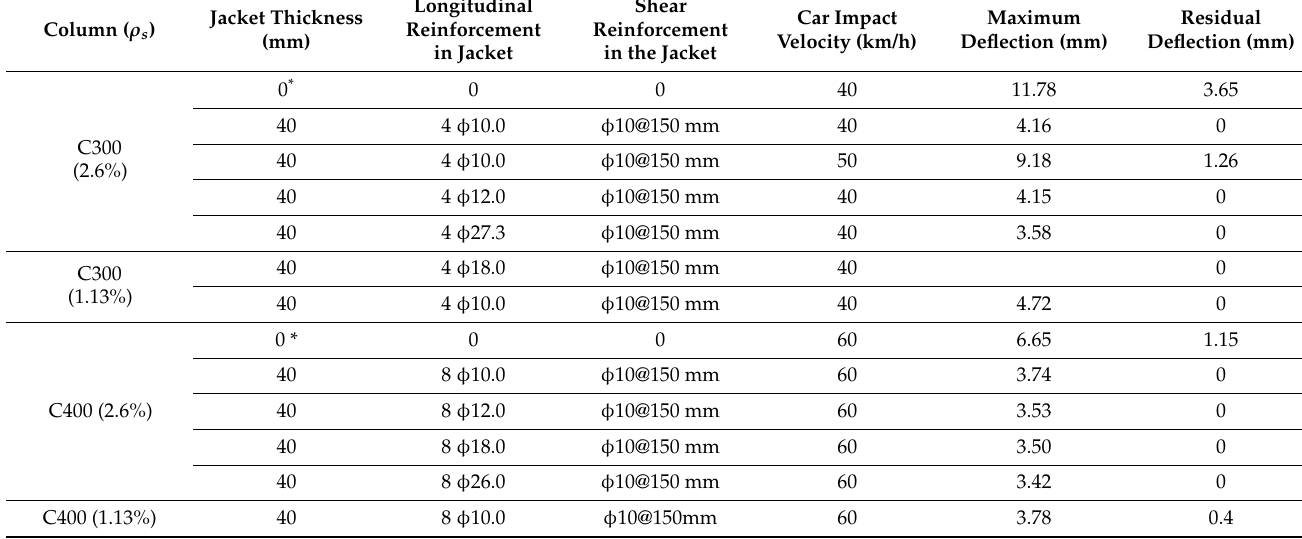
Table 3. Performance of columns with RC jackets against car impact.